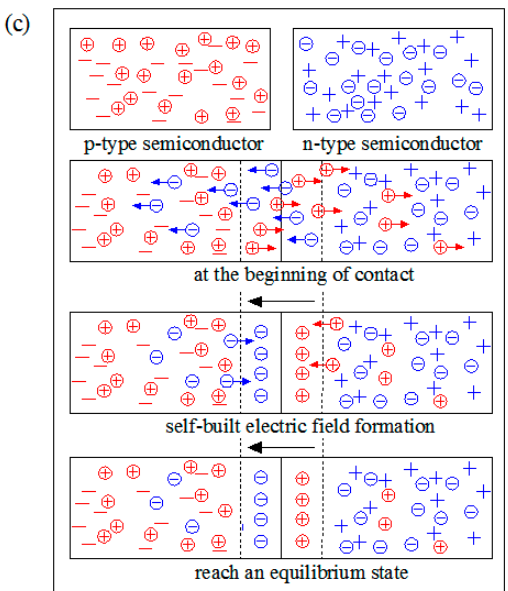
Figure 9. Energy band diagrams for ( a ) Cu 2 O and TiO 2 before contact; ( b ) Cu 2 O/TiO 2 composite; ( c ) Charge variations before and after contact of different types of semiconductors.